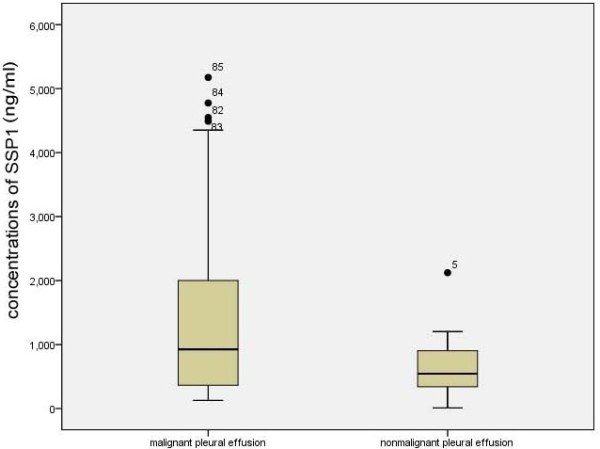
The box plot of concentrations of SSP1 of malignant pleural effusion and nonmalignant pleural effusion.